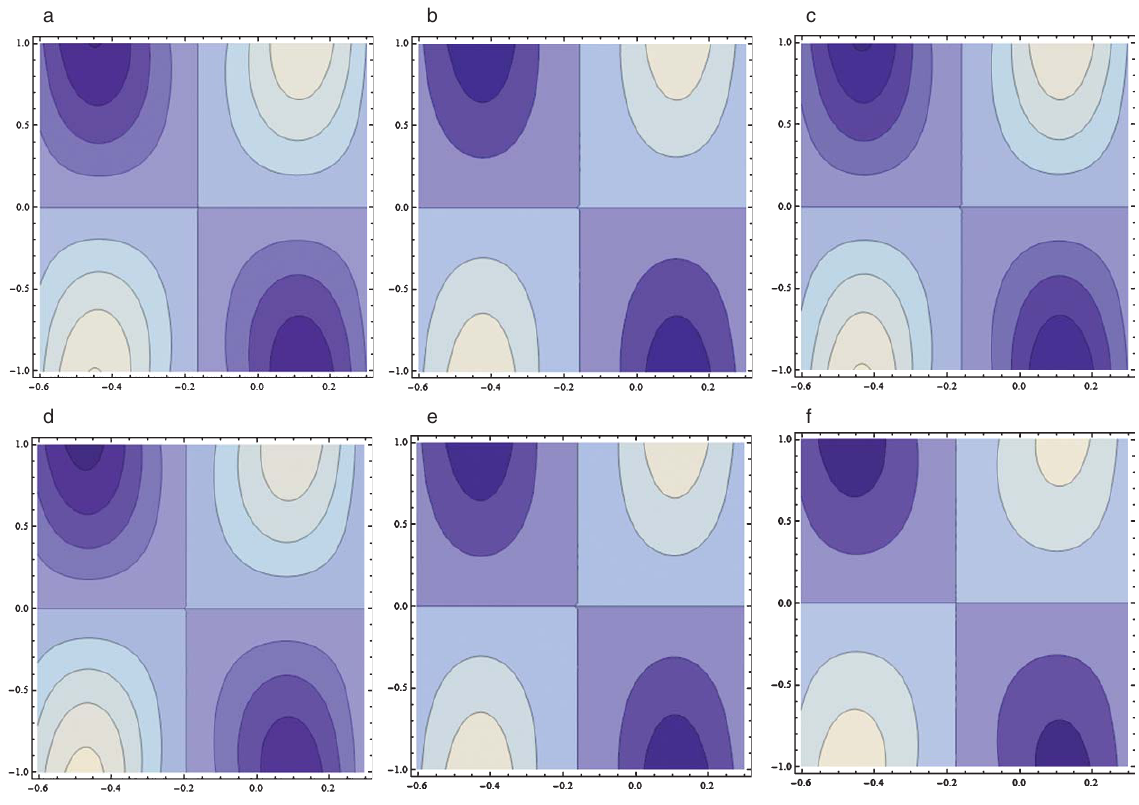
Fig. 8. Variation of wall properties on ψ for M = 2 , t = 1 ,β = 0 . 02 , α = 1 . 5 , (cid:11) = 0 . 2 , when (a): E 1 = 0 . 7 , E 2 = 0 . 4 , E 3 = 0 . 2 , E 4 = 0 . 02 , E = 0 . 5 , (b): E 5 E = 0 . 4 , E 2 E = 0 . 01 , E 4